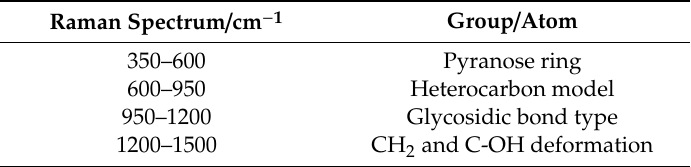
Table 4. Raman spectrum of polysaccharide functional